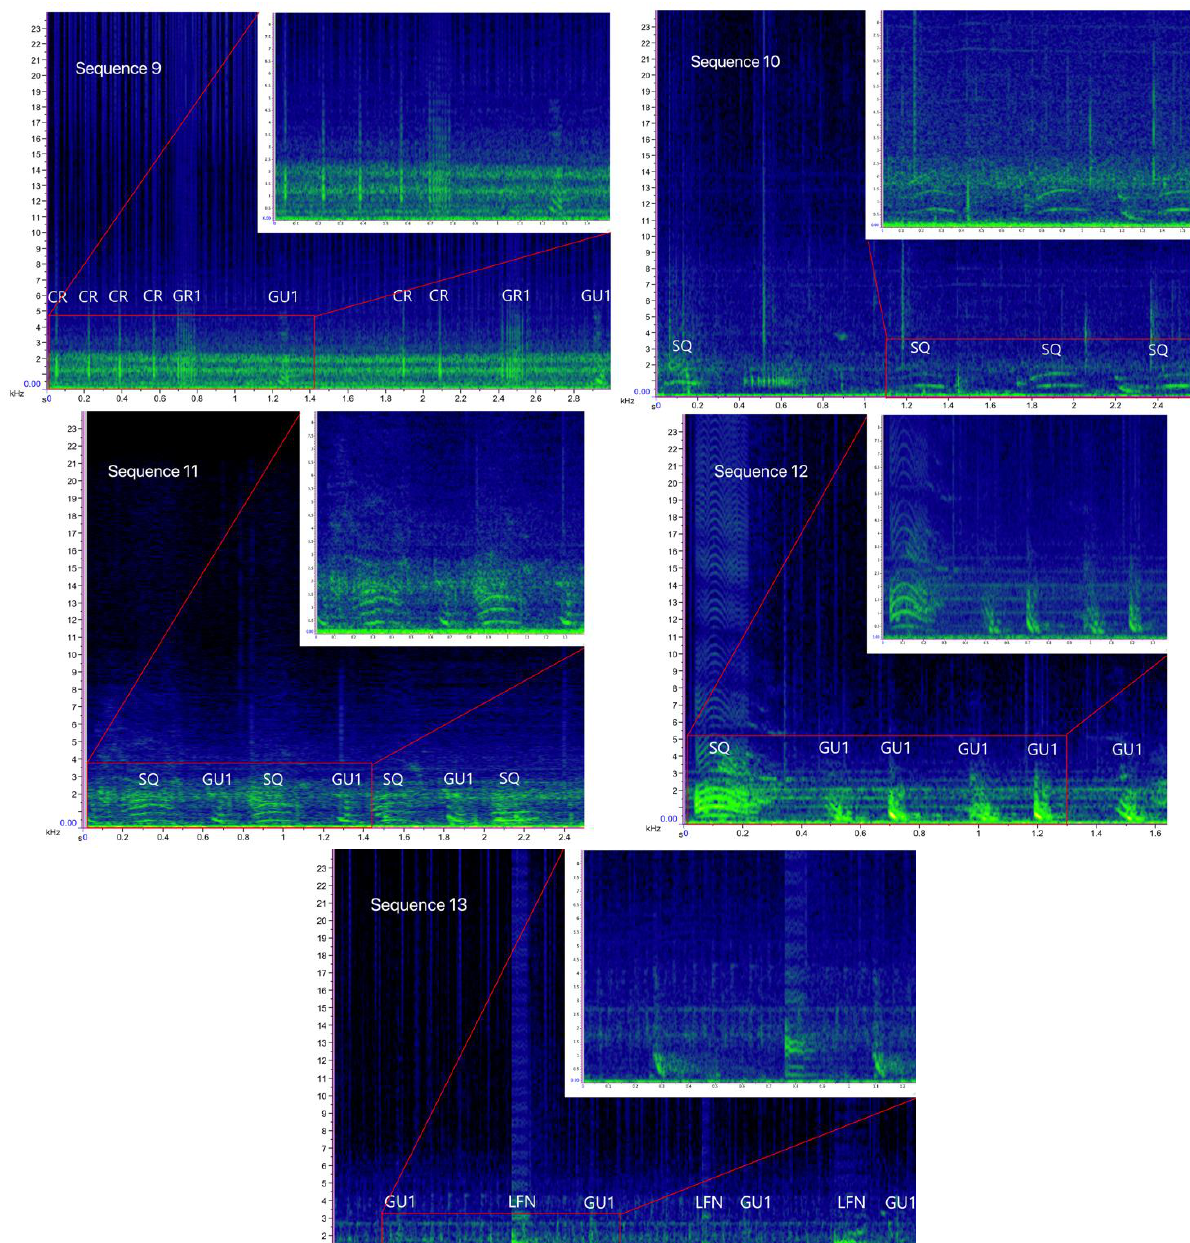
Figure 5 . Spectrograms of the bray-call sequences 9 – 13 identified in the present study (main panels: Hann window, size 2048, DFT 2048, overlap 50%, hop size 1024, sampling frequency 192 kHz, frequency resolution 93.75 Hz, analysis bandwidth 135 Hz at -3 dB); zoomed panels: Hann window, size 3000, DFT 4096, overlap 80%, hop size 600, sampling frequency 192 kHz, frequency resolution 46.875 Hz, analysis bandwidth 92.16 Hz at -3 dB).